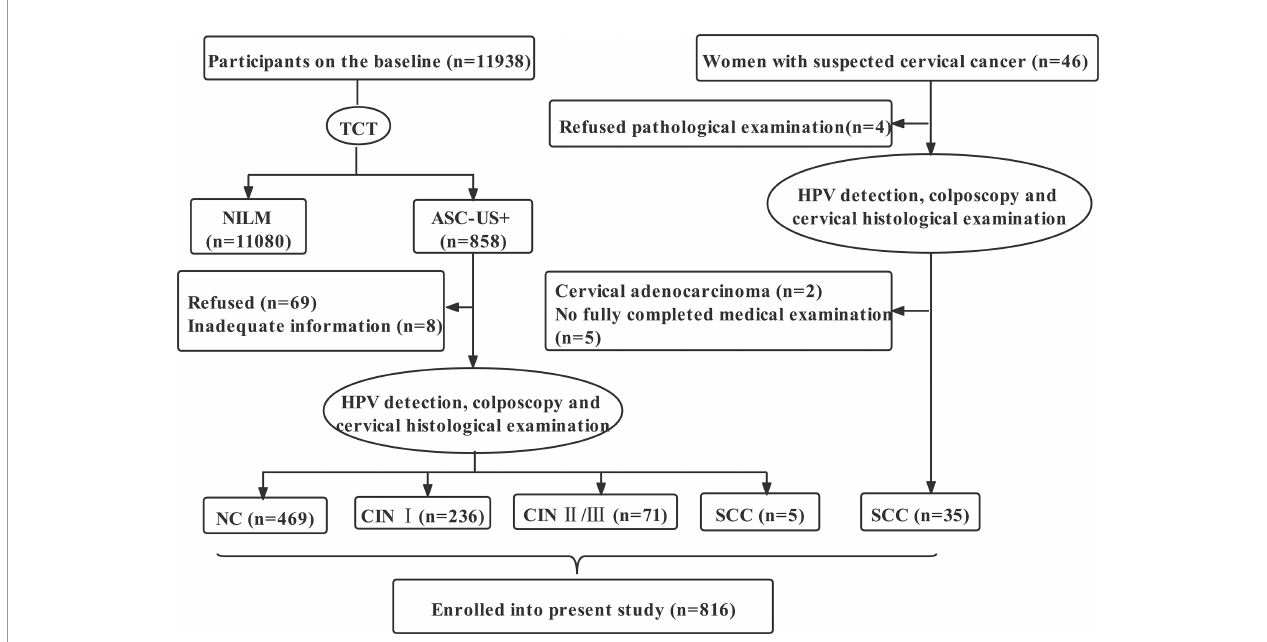
FIGURE 1 | Flowchart of participants in the study. TCT, ThinPrep cytologic test; NILM, negative for intraepithelial lesion or malignancy; ASC-US+, atypical squamous cells of undetermined signi fi cance and above; NC, normal cervical; CIN I, low-grade cervical intraepithelial neoplasm; CIN II/III, high-grade cervical intraepithelial neoplasm; SCC, squamous cell carcinoma; HPV, human